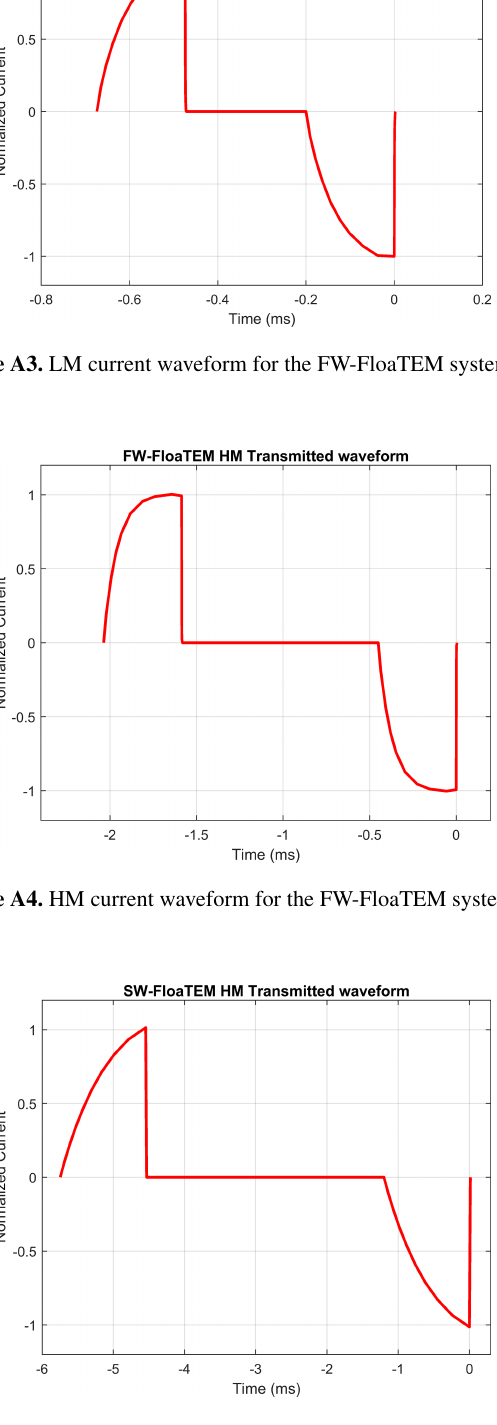
Figure A5. HM current waveform for the SW-FloaTEM